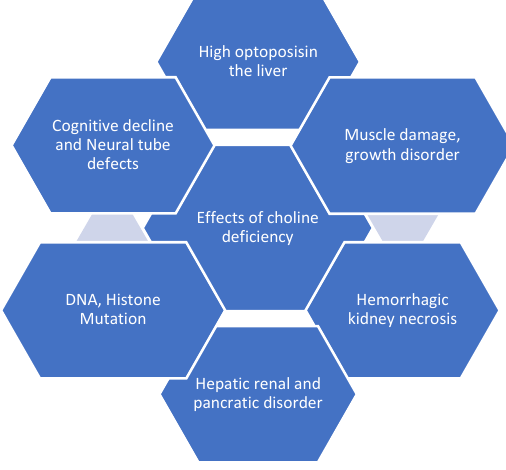
Figure 3. Health effects of choline deficiency.